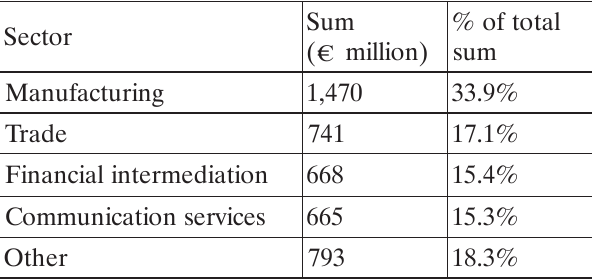
priorities in Estonian economic development